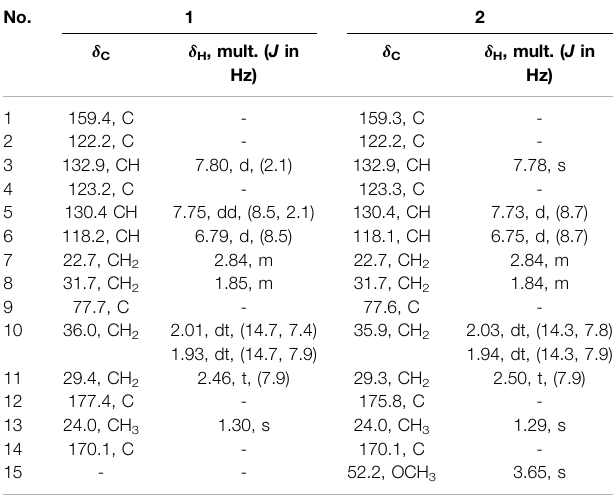
TABLE 1 | 1 H and 13 C NMR data for 1 and 2 (500 and 125 MHz, δ in ppm) in